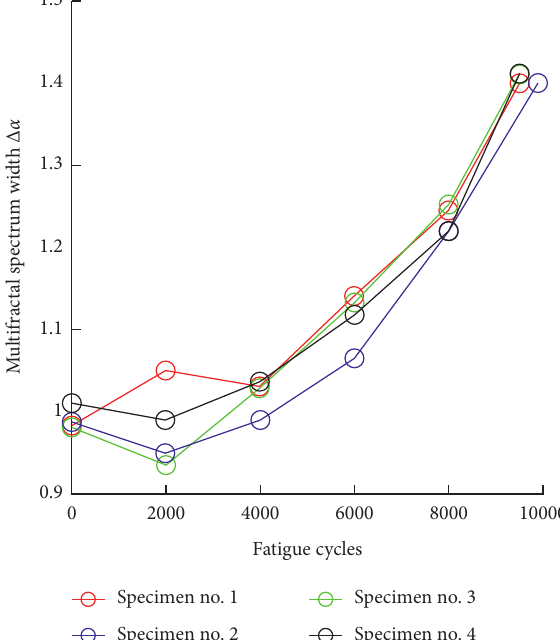
Figure 9: Variation curves of multifractal spectrum width.